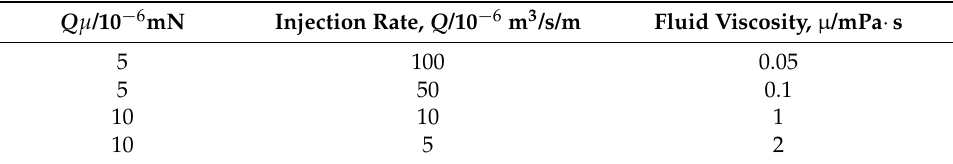
Table 3. Different combination of the injection rate and viscosity.